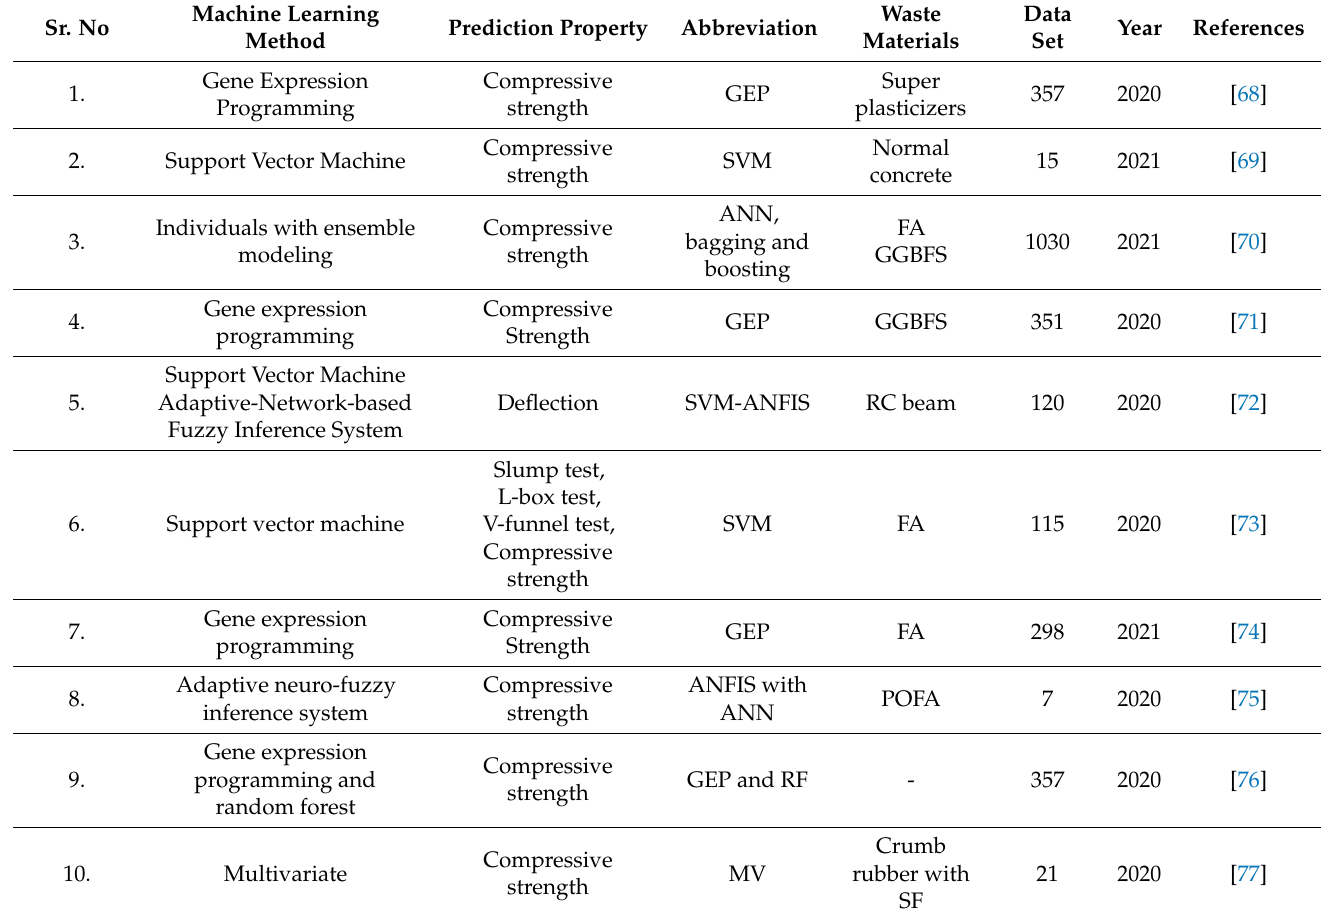
Table 1. MLA in civil engineering